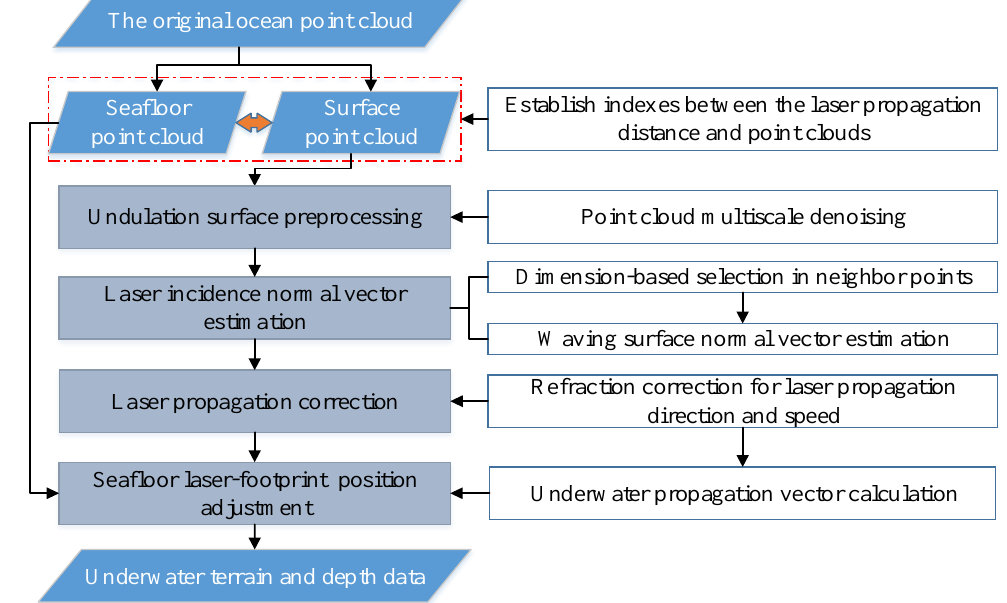
Figure 2. Flow chart of laser incidence correction for ocean surface undulations.